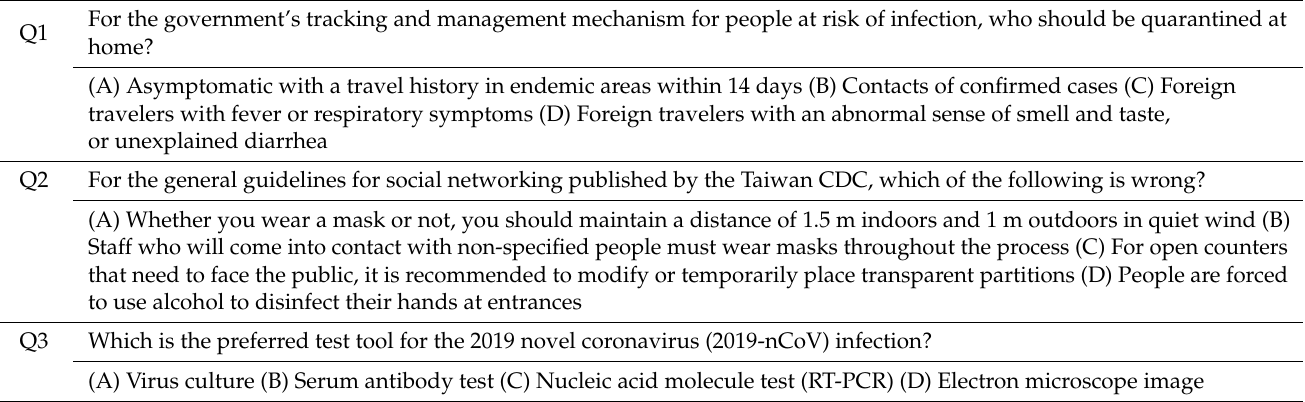
Table 5. COVID-19 Online Test Advanced Questions 28-Apr-2020